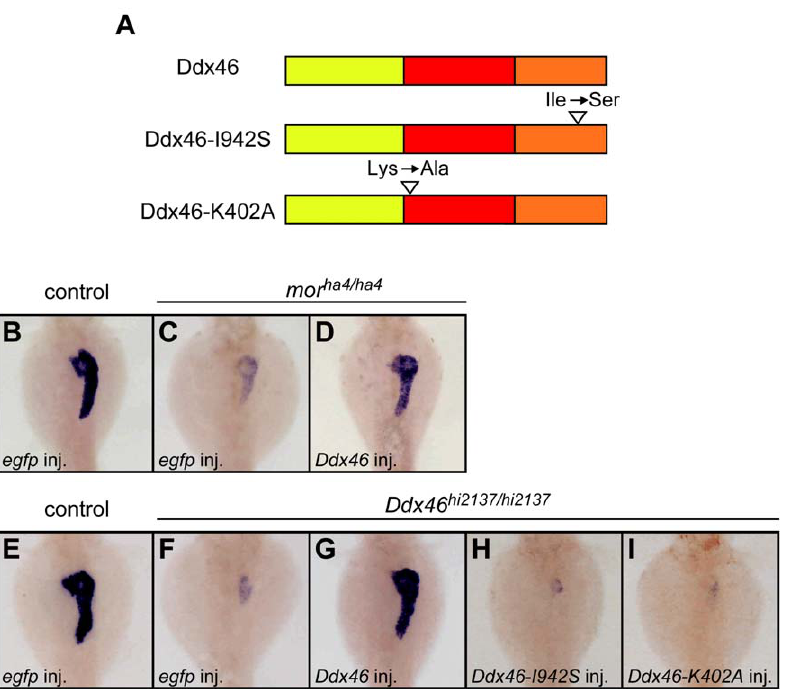
Figure 3. Defects of exocrine pancreas formation in both mor ha4/ha4 and Ddx46 hi2137/hi2137 mutants are rescued by the overexpression of Ddx46 mRNA but not mutated Ddx46 mRNA. (A) Scheme of the Ddx46 protein structure. The yellow, red, and orange boxes indicate the N- terminal, DEAD-box helicase, and C-terminal domain, respectively. Mutations were introduced into the Ddx46 protein; in Ddx46-I942S, an isoleucine in the C-terminal domain of Ddx46 was changed to serine, which is the same mutation as that in the mor ha4 mutant; in Ddx46-K402A, GKT in motif I, which is important for ATPase activity in Ddx46 homologues, was changed to GAT. (B–I) All dorsal views, anterior to the top. The expression of try , a molecular marker for the exocrine pancreas, was examined using whole-mount in situ hybridization at 3.5 dpf. The try expression in the exocrine pancreas was markedly reduced in egfp mRNA-injected mor ha4/ha4 (C) and Ddx46 hi2137/hi2137 mutants (F) compared to egfp mRNA-injected control larvae (B, E). The try expression was rescued in the Ddx46 mRNA-injected mor ha4/ha4 (D) and Ddx46 hi2137/hi2137 mutants (G), whereas no rescue was achieved by the overexpression of Ddx46-I942S (H) or Ddx46-K402A (I) mRNA into Ddx46 hi2137/hi2137 mutants. Control larvae-sibling WT or mor ha4/ + larvae (B–D), sibling WT or Ddx46 hi2137/ + larvae (E–I)-had normal